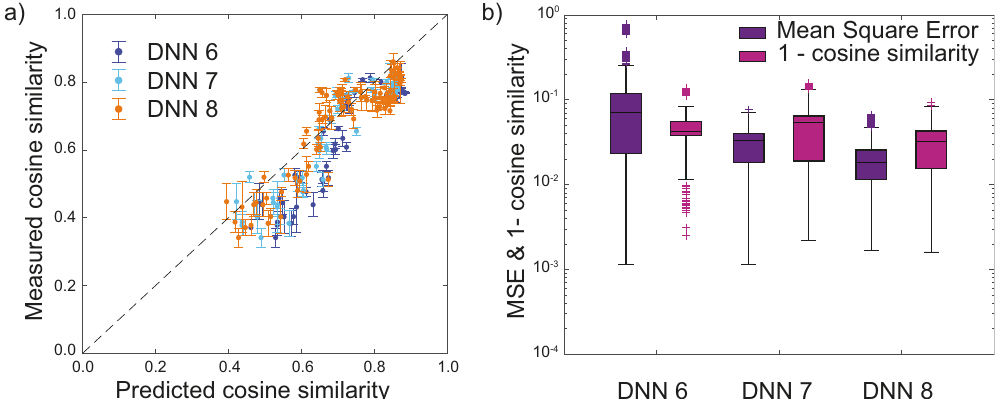
Fig. 4 DNN regression validation. a The measured cosine similarity (cosine similarity between the target spectrum and the experimental spectrum) is compared to the predicted cosine similarity (cosine similarity between the target spectrum and the DNN predicted spectrum at runs 6, 7 and 8). All the data that were not used for training the DNN are used for this validation step: all the DNN data, the BO data from the last run, and the random sampling data. The error bars represent the standard deviation of the measured cosine similarity on the droplet replicas of a condition. The alignment of the data with the diagonal shows that the DNN is able to predict the spectral shape correctly. b Evolution of the cosine similarity and the mean squared error (MSE) between the spectra predicted by the DNN and the spectra measured at each run, for the conditions suggested by both BO and DNN in that run. The box plots show the distribution of these values considering all the droplet samples of the run.